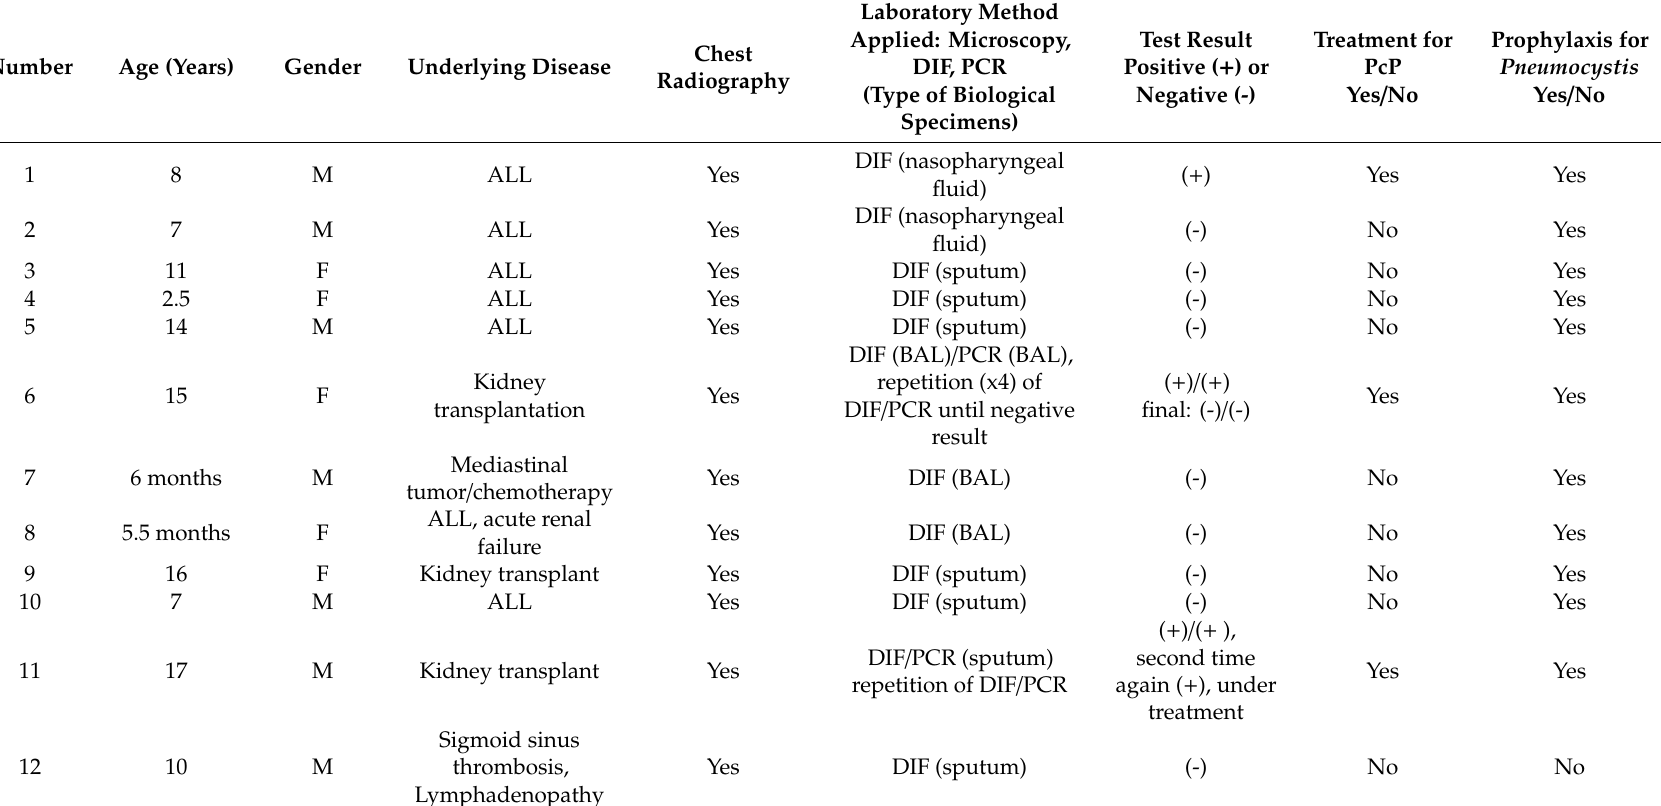
Table 2. An example of available data concerning underlying diseases and laboratory approaches of 12 pediatric cases, clinically suspected for Pneumocystis pneumonia (PcP) and referred to a single reference laboratory during 2014 to 2019 (data of the First Department of Microbiology, Medical School, Aristotle University of